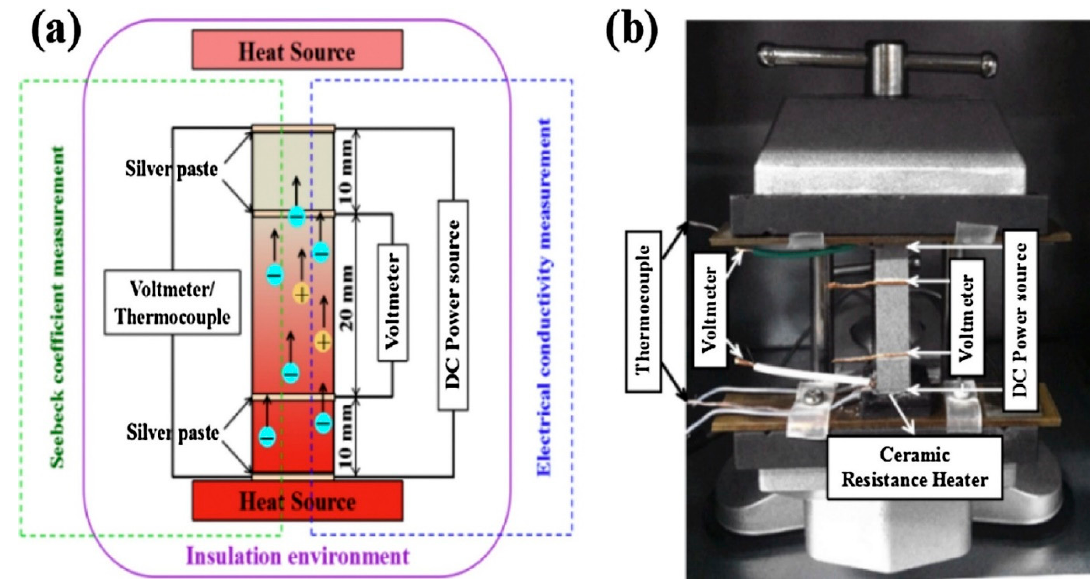
Figure 24. Laboratory setup for evaluating the seebeck coefficient and electrical conductivity ( a ) The test principle diagram and, ( b ) the experimental setup. Reproduced with permission from [166], Elsevier, 2018. Table 4. Thermoelectrical properties of graphene based cement composite.